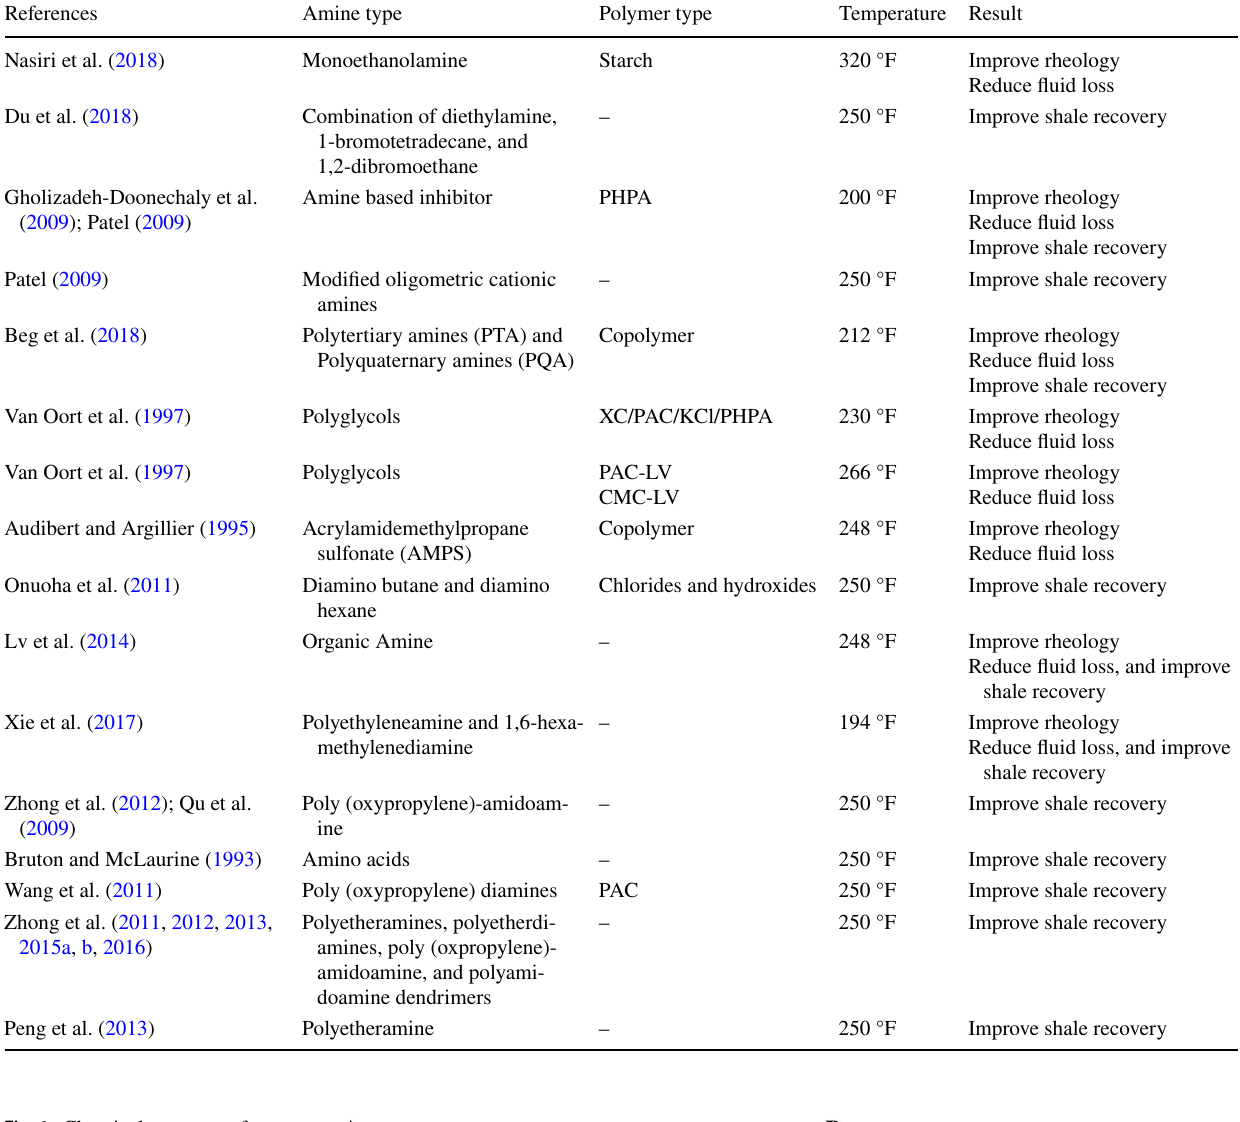
Table 1 Literature review of the available studies on the effect of amines on properties of drilling fluids